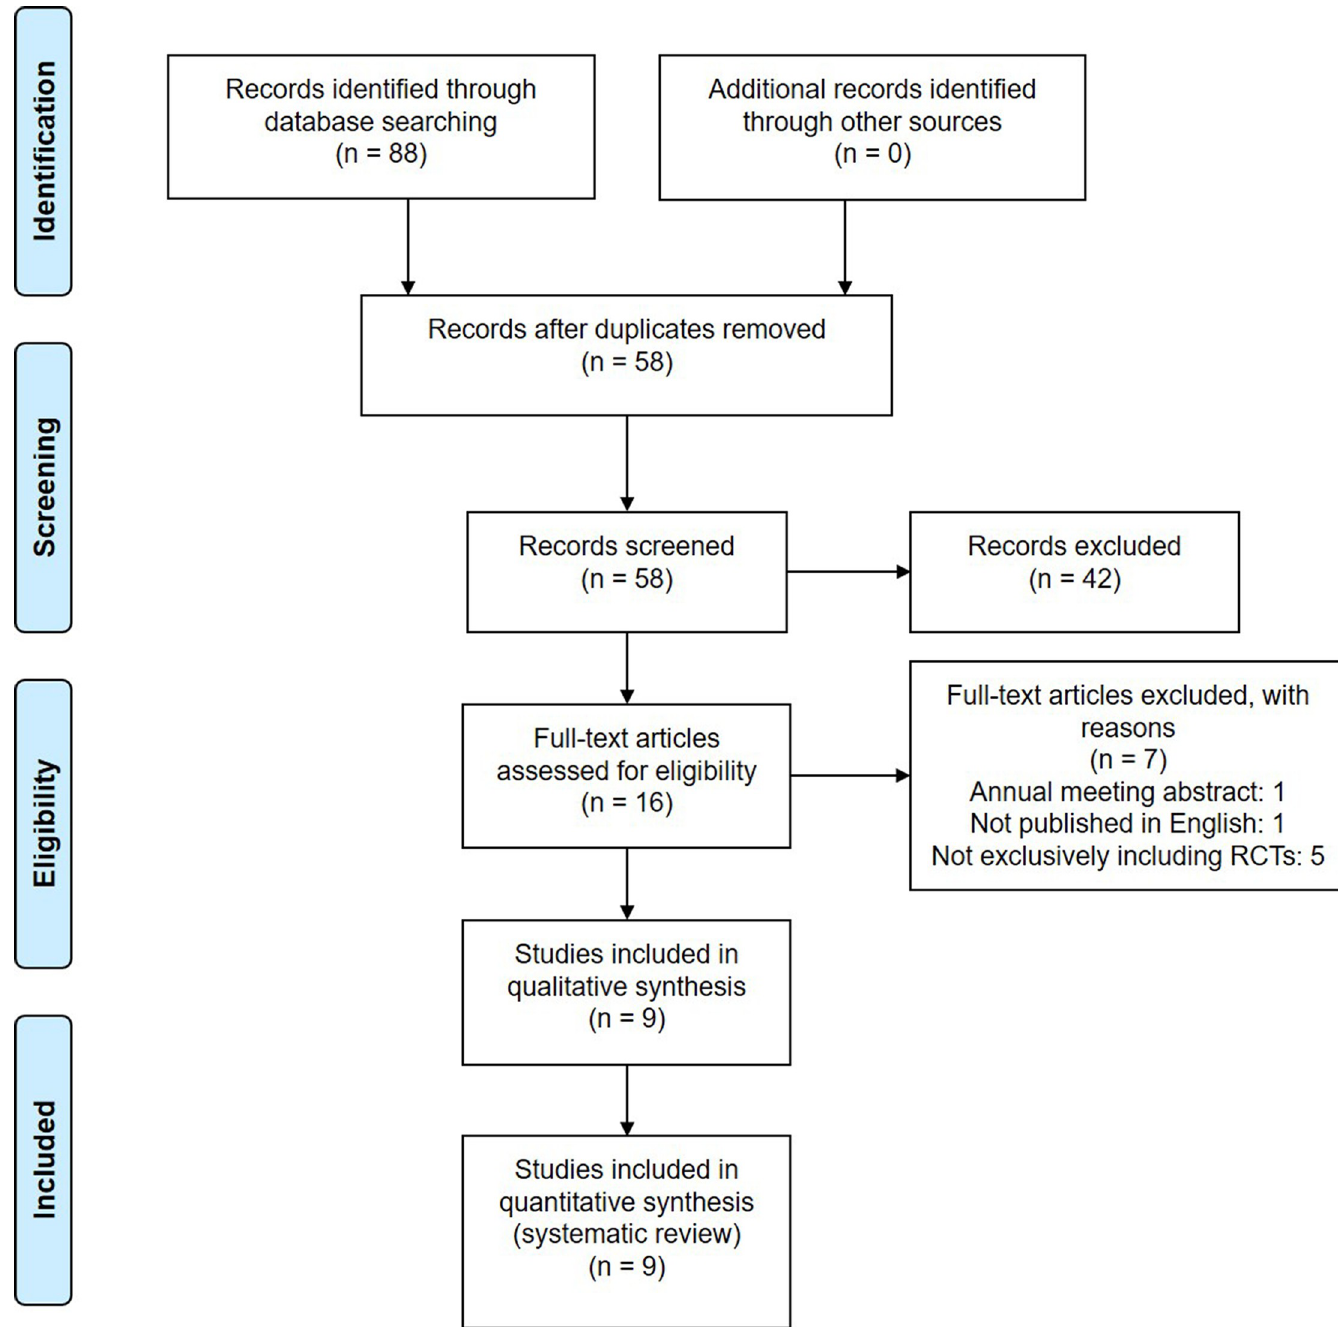
Fig 1. PRISMA flow